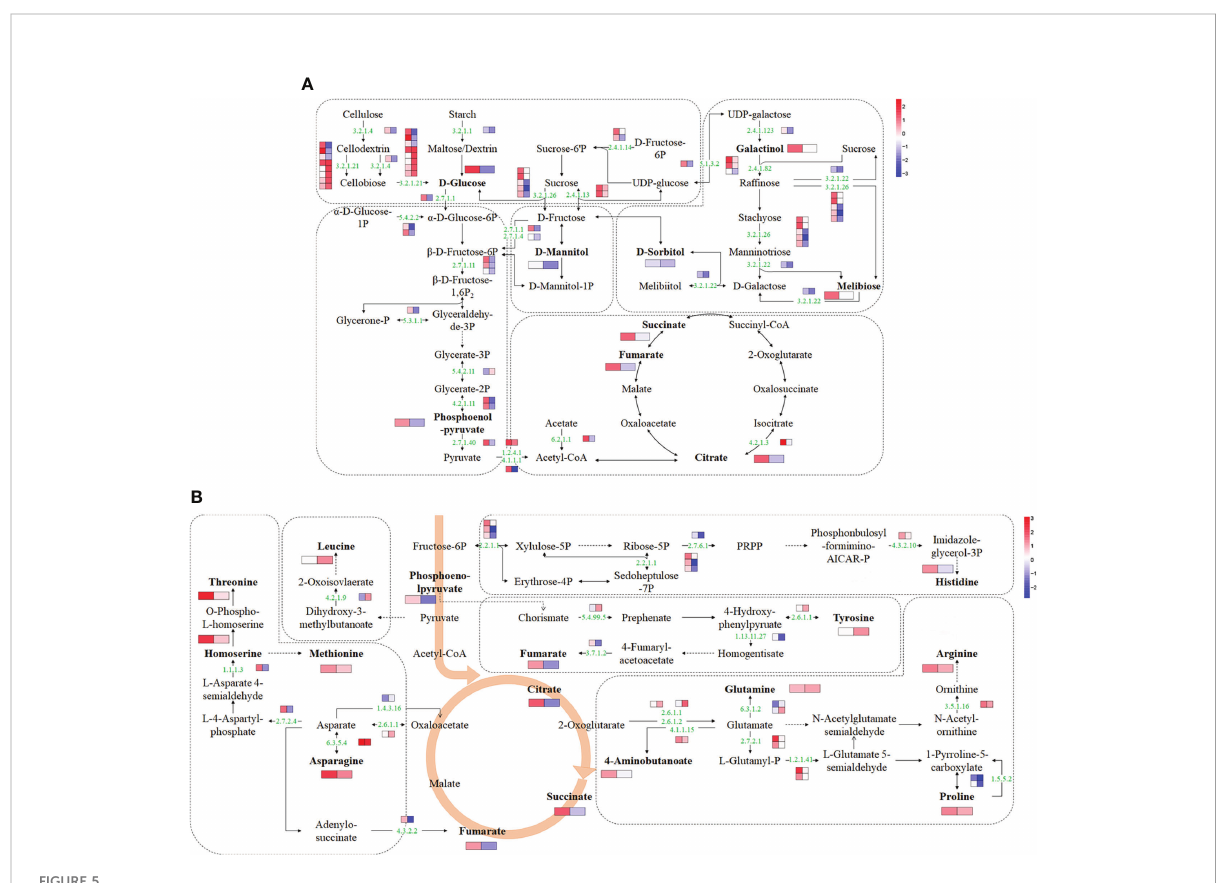
FIGURE 5 Schematic networks of the sugar metabolism (A) and amino acid metabolism (B) . The metabolites in bold were identi fi ed as differential metabolites in this study. The numbers in green are enzyme identi fi er numbers. Omitted metabolic processes are represented by dashed lines. The icons with two blocks that are colored in a gradient color — from low (blue) to high (red) for each DEG (small blocks) or differential metabolite (large blocks) — are the log of fold change (log 2 FC) in ‘ jx1502 ’ and ‘ gold crown ’ under salt